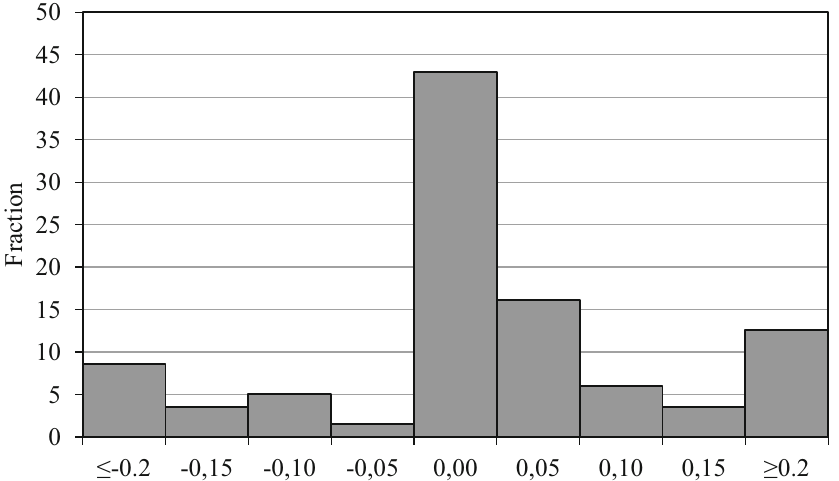
Fig. 1 Histogram of all changes in old age pensions. Notes: measures as percentage of previous period nominal GDP. All countries, 2007–2015